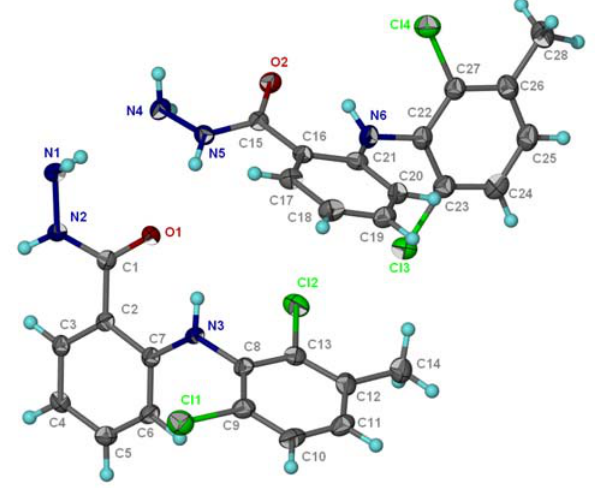
Figure 1. X-ray structure of hydrazide 3c